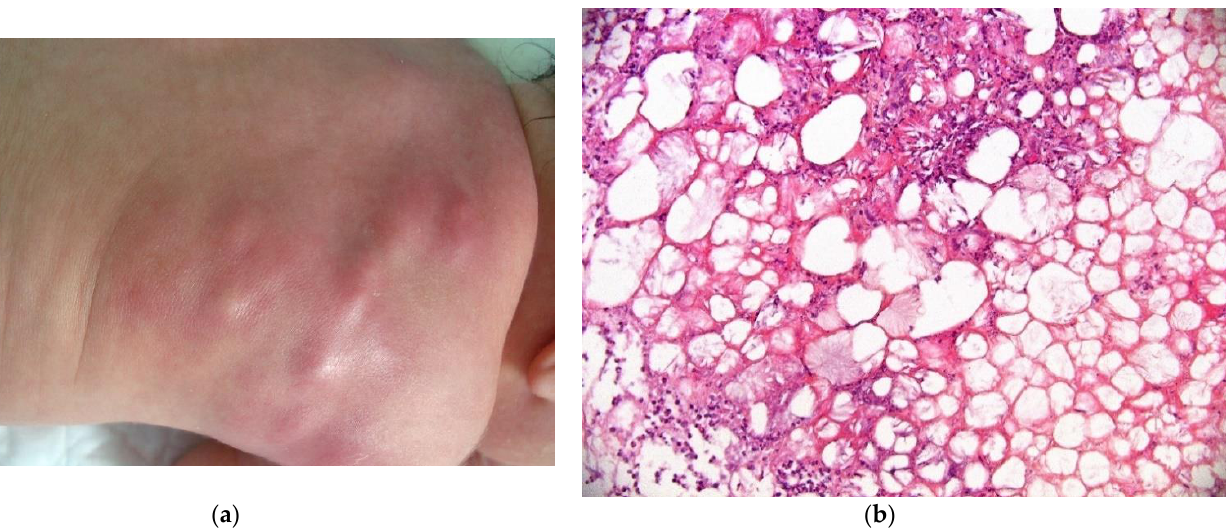
Table 2. Multifocal neonatal vascular skin lesions.